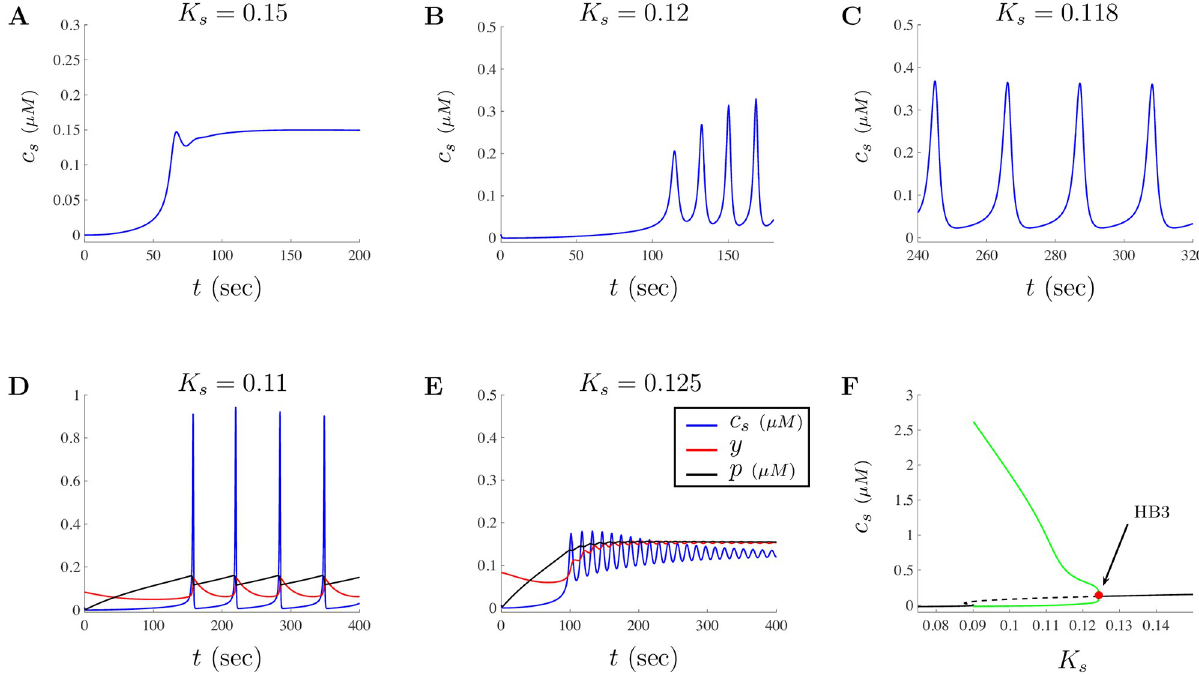
Fig 3. Model solutions mimic experimental Ca 2+ patterns for doses of a = 1 μ g/ml of A β . The dependence of model solutions for a dose of 1 μ g/ml of A β on the cellular parameter K is investigated. A shows an increasing Ca 2+ signal that settles to an increased steady-state when K s oscillations in Ca 2+ can exhibit increasing amplitudes such as those found in Fig 1D in [18]. C and D show that as the value of K s decreases, the oscillatory patterns of the model reproduce the spike-like Ca 2+ signals observed in Fig 1E in [18]. E illustrates an oscillatory solution with an increased steady-state Ca 2+ homeostasis level when K s is just above the Hopf point. Both D and E show the traces for c s , y , and p in blue, red, and black, respectively. F shows a simplification of the scaled bifurcation diagram with the bifurcation parameter K value of 0.15, a transition from stable steady-states into periodic oscillations occurs through a Hopf bifurcation around HB3 � 0.1242. The dynamics around K = 0.09 include multiple Hopf bifurcations and has more complex structure than what is presented here. s